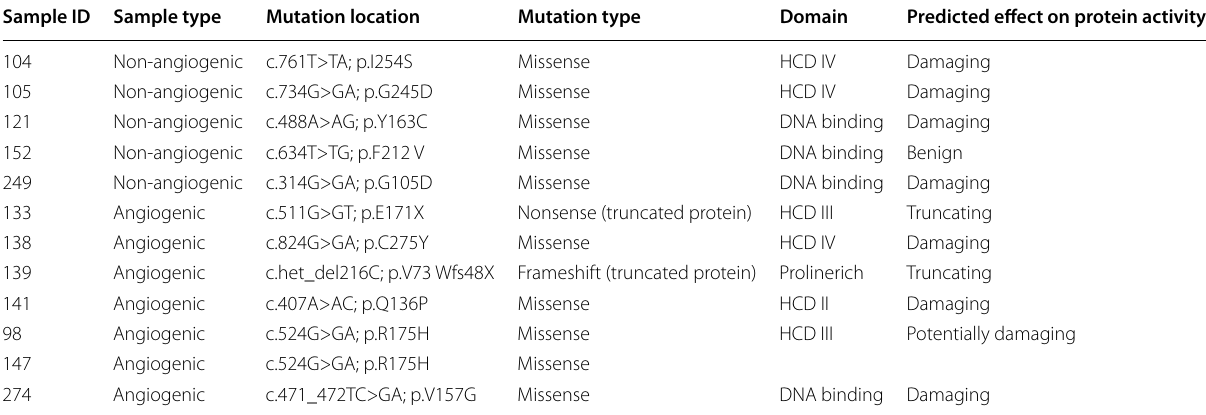
Affected domains are listed. The software used to predict the functional effect of the detected sequence changes was PolyPhen_2 (http://genetics.bwh.harvard.edu/ ggi/pph2/c2ea64efde6f039a5ca76a2a264ae4f3cf922360/1121012.html) HCD highly conserved domain